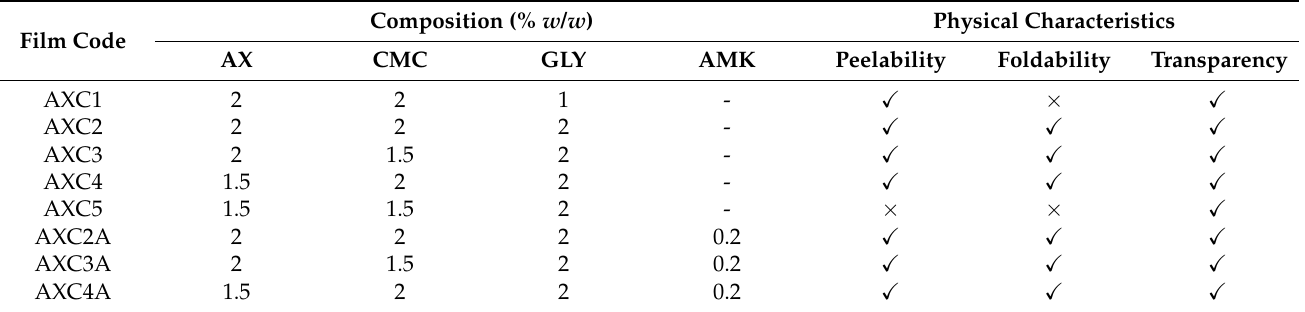
Table 1. Composition and physical characteristics of the AMK-loaded AX-CMC composite